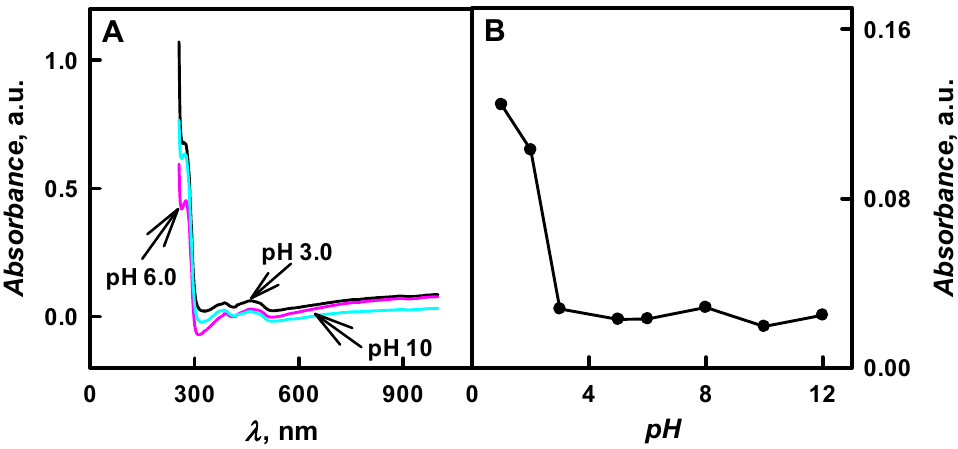
Figure 4. ( A ) Spectra of PTh/GOx composite nanoparticles colloidal solutions formed at various solution pH values and ( B ) dependence of optical absorbance at λ max = 450 nm on the solution pH. (The composition of polymerization solution: 0.05 mol L − 1 of glucose, 0.50 mol L − 1 of thiophene, and 0.75 mg mL − 1 of glucose oxidase at pH 1.0–12; 48 h lasting polymerization was performed. Optical absorbance was registered in 0.05 mol L − 1 SA buffer, pH 6.0).